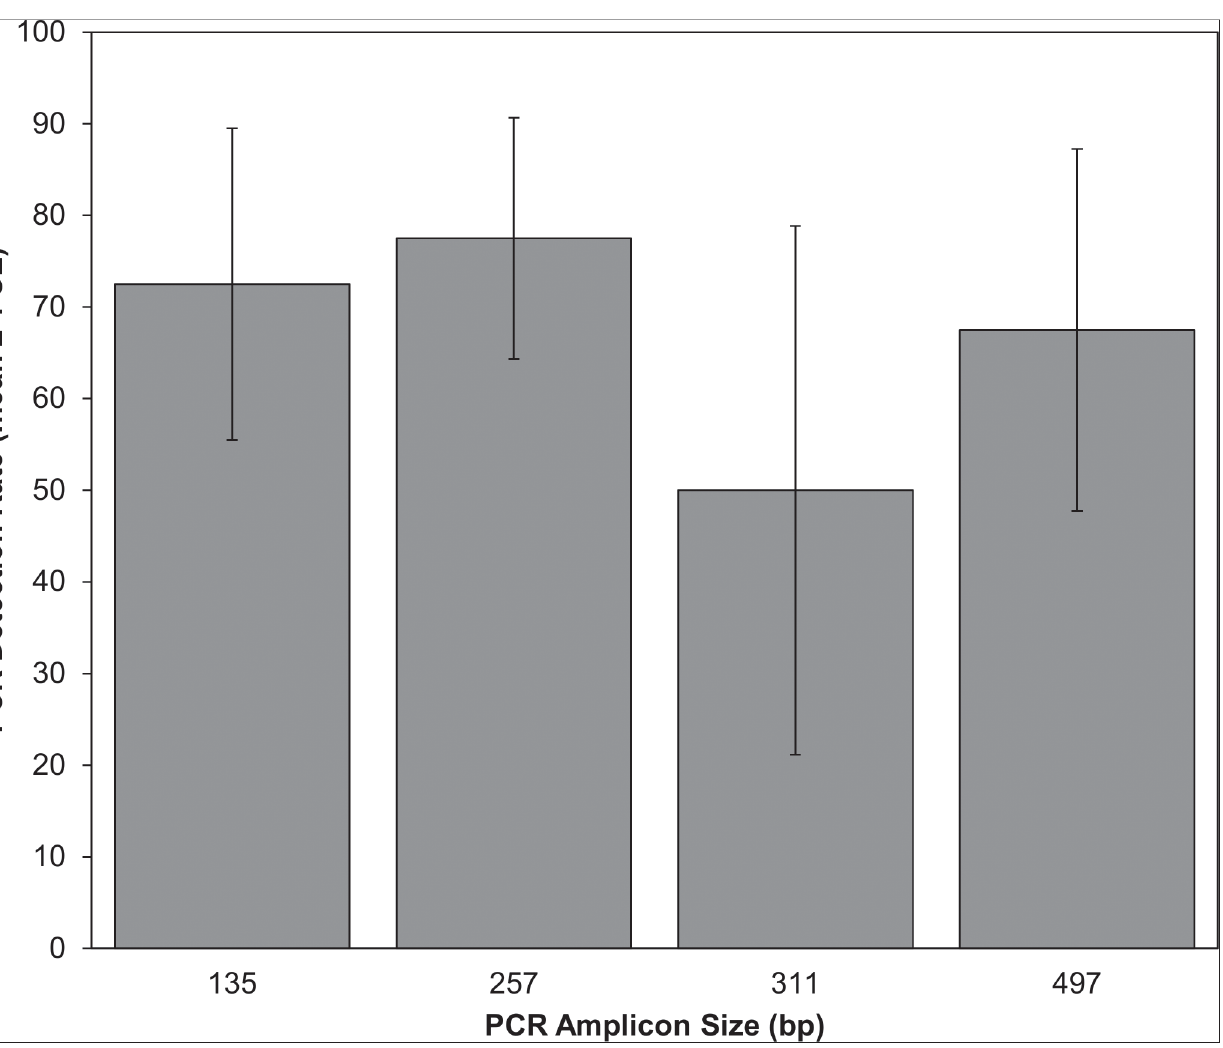
Fig 2. Success of different amplicon sizes in detecting the cytochrome c oxidase subunit I (COI) of Latrodectus spp. from web samples. Percent success calculated from number of successful PCRs out of 10 technical replicates. Error bars represent ± 1 standard